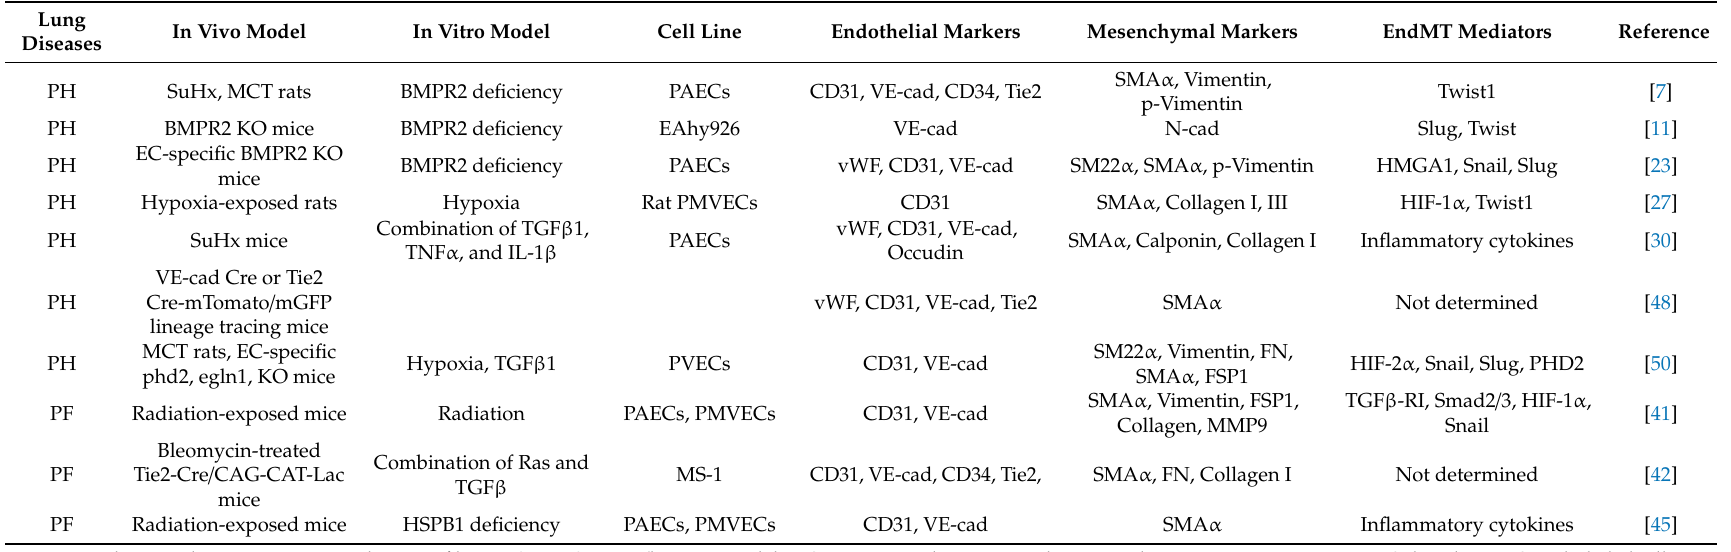
Table 1. Summary of the main studies on EndMT in lung